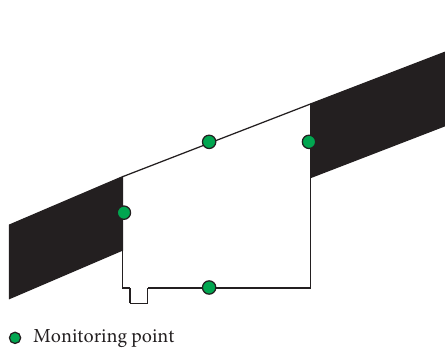
Figure 3: Layout of monitoring